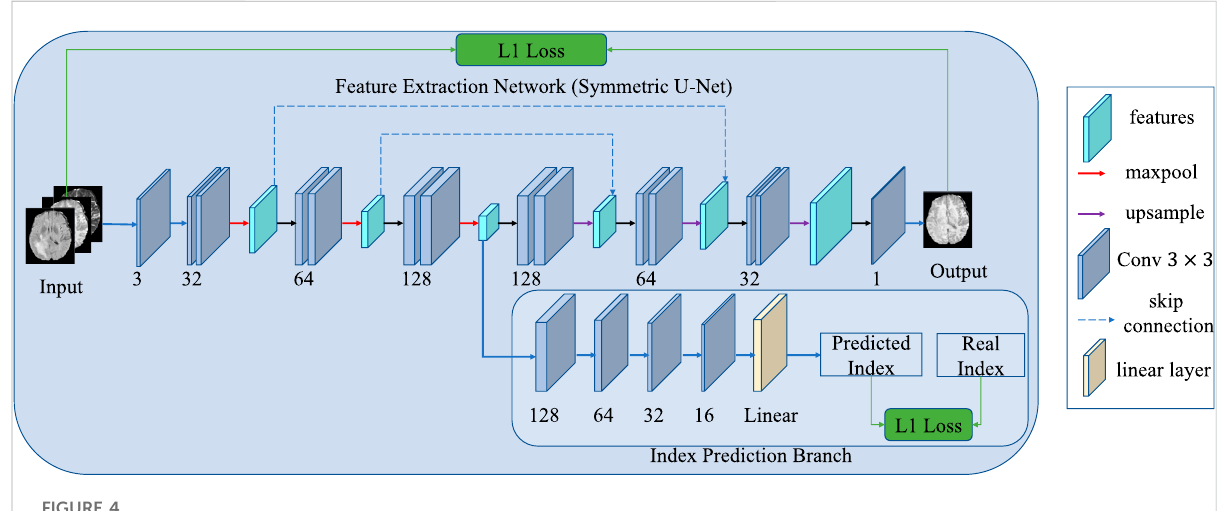
FIGURE 4 Schematicdiagramoftheindexpredictiontask. Comparedwith theoriginalnetwork,anextra branchisusedtopredicttheindexofthepresent slice, and the input images contain three neighboring slices rather than